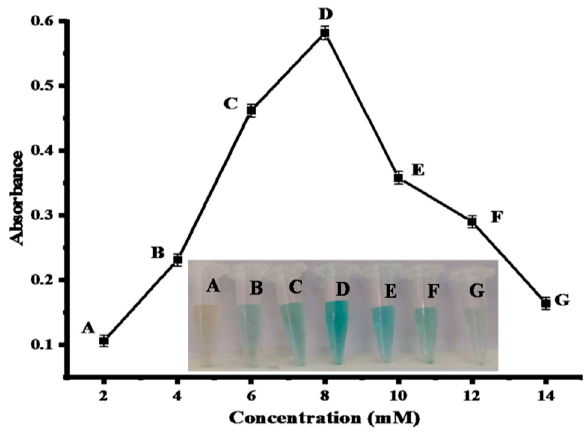
Figure 10. Optimization of TMB. Reaction conditions: TMB = 180 µL (8 mM), capped amount of Co- CeO 2 /C/IL = 50 µL, PBS = 500 µL (pH = 7.0), H 2 O 2 = 85 µL (6 mM).